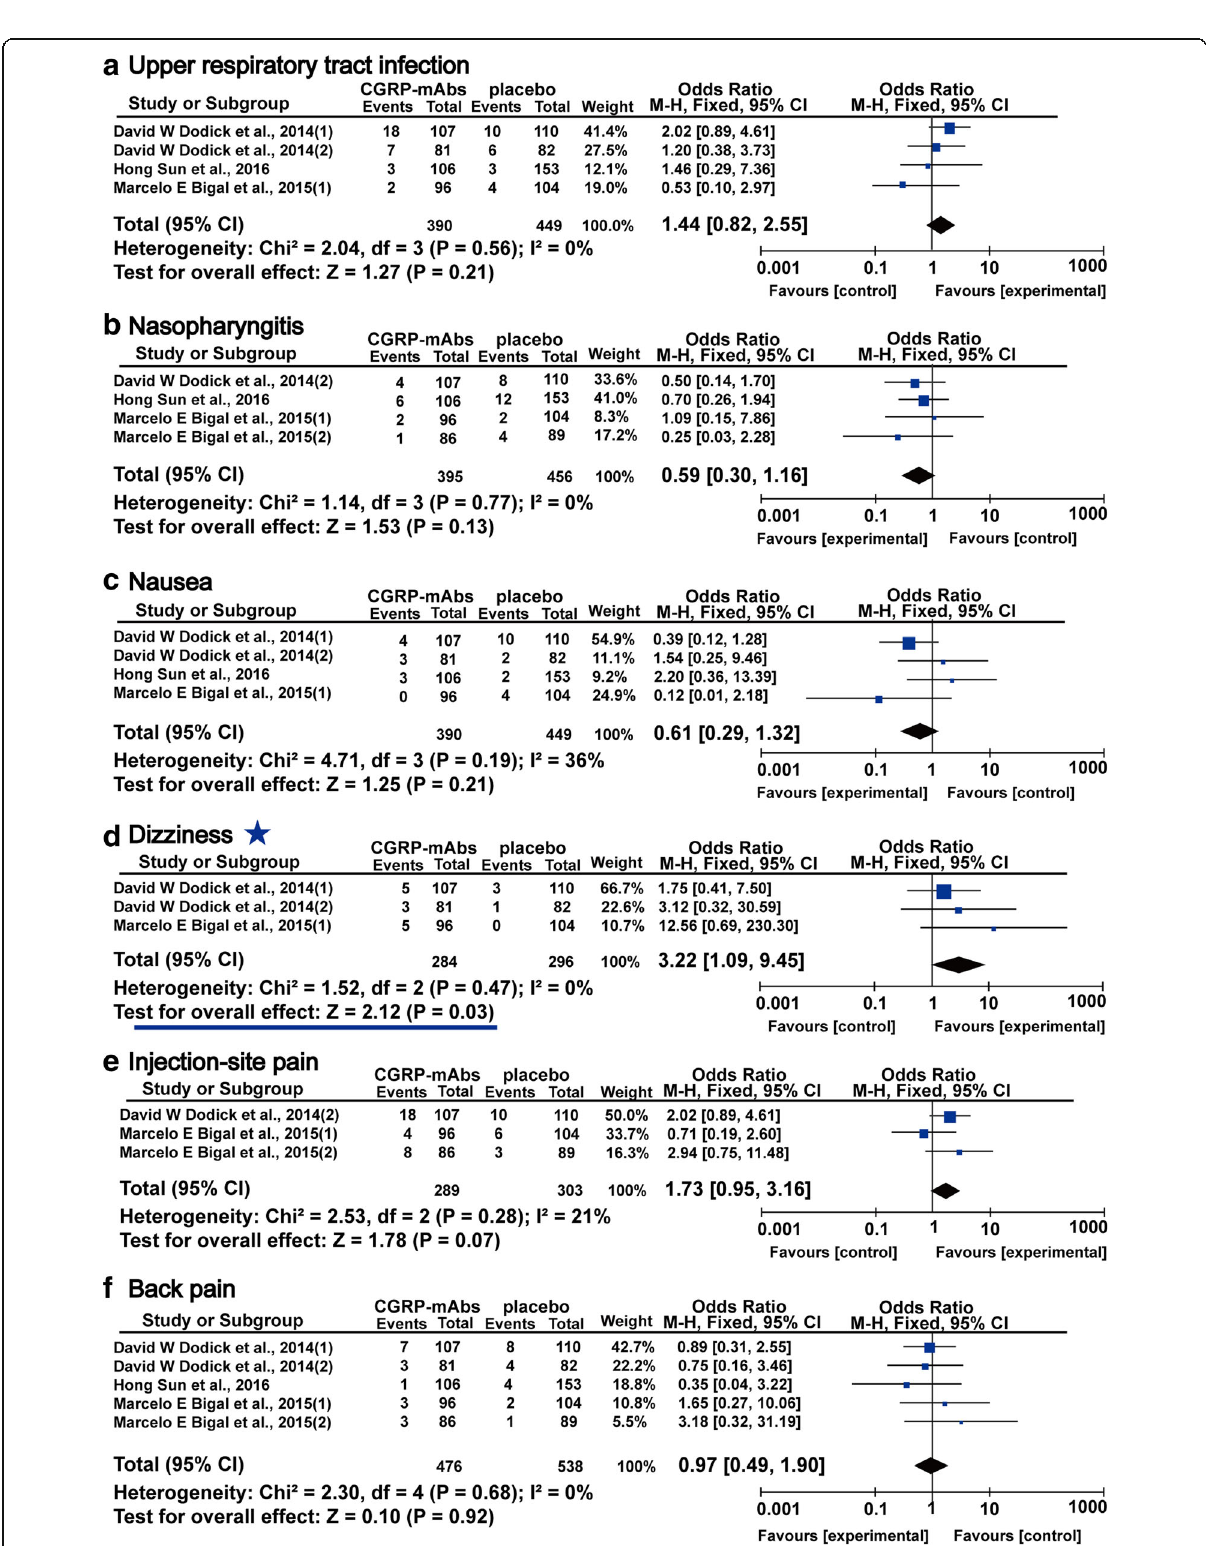
Fig. 10 Forest plot of the meta-analysis showed non-significant difference in main adverse events of CGRP-mAbs compared with placebo. upper ( a ), respiratory tract infection; ( b ), nasopharyngitis; ( c ), nausea; ( d ), dizziness; ( e ), injection-site pain; ( f ), back pain. CGRP-mAbs, monoclonal antibodies to CGRP and its receptor; M-H, Mantel-Haenszel; CI, confidence interval. ★ The significant result was labeled with an